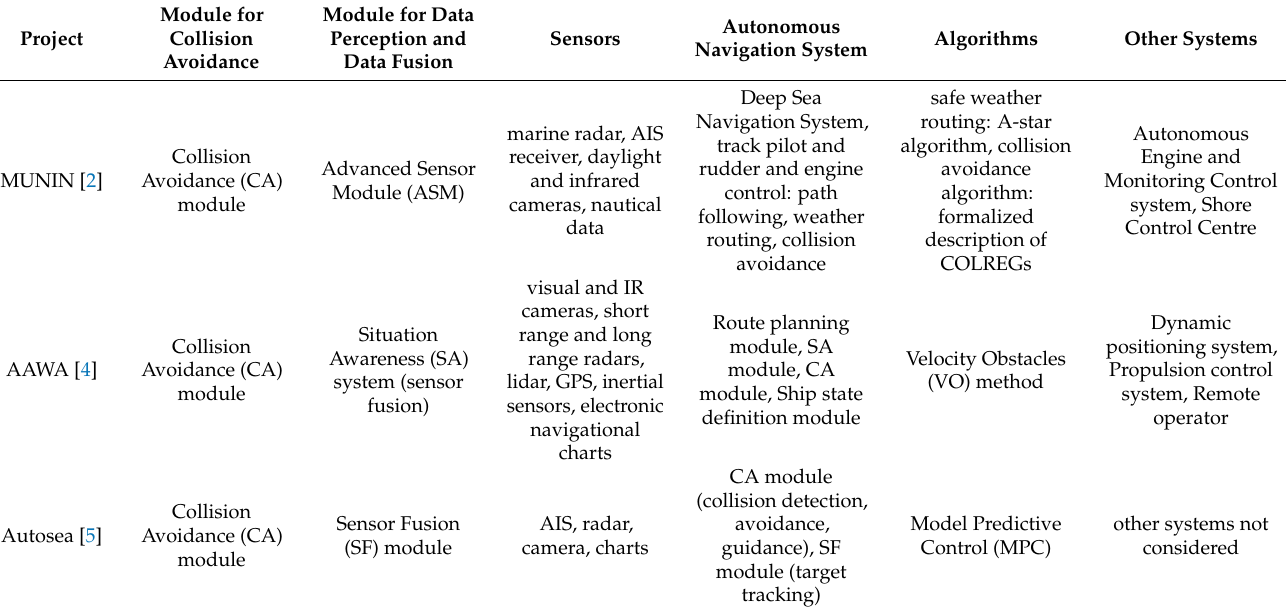
Table 4. ANSs in research projects on autonomous